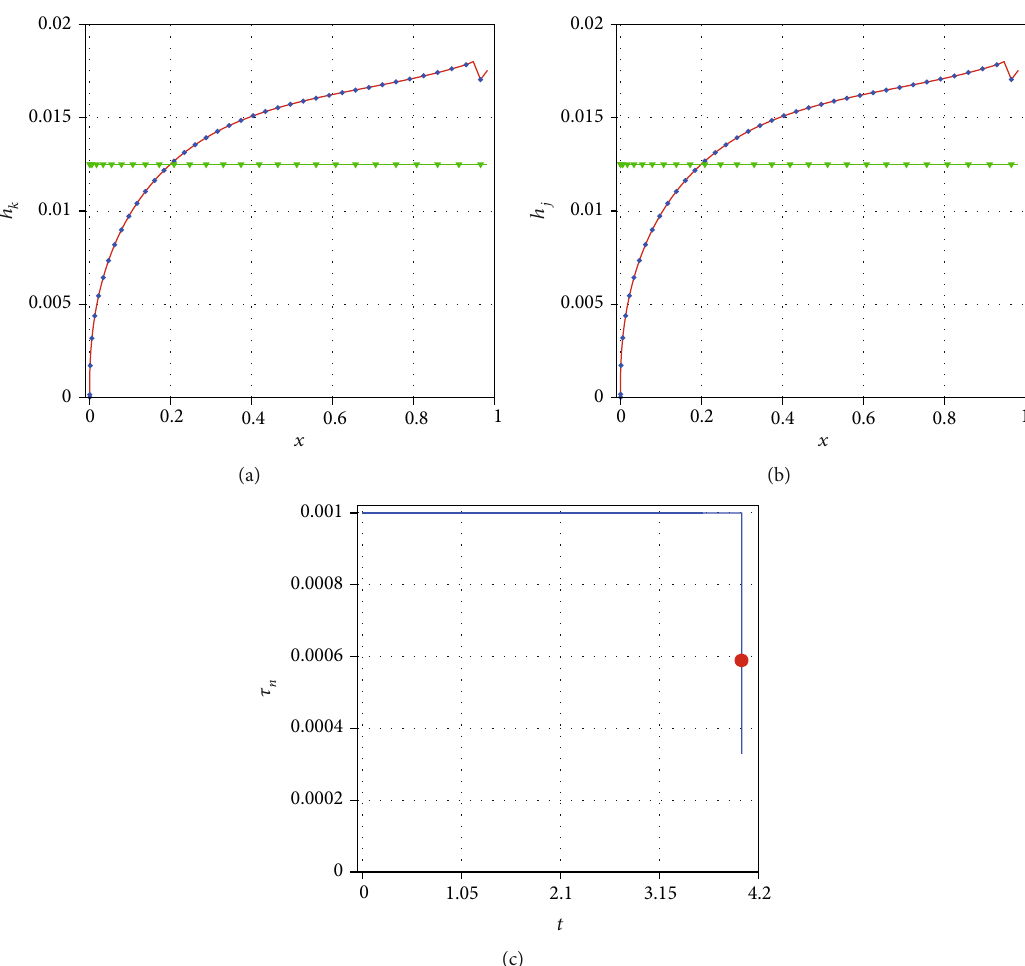
x processes; (b) the variation of spatial step h k as space